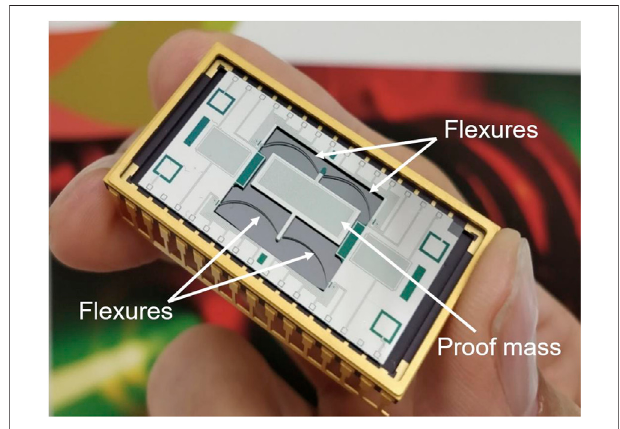
FIGURE 2 | The microelectromechanical systems gravimeter silicon layer (32.8 mm × 18.3 mm) in its ceramic-lead hybrid package (40.6 mm × 23.1 mm).